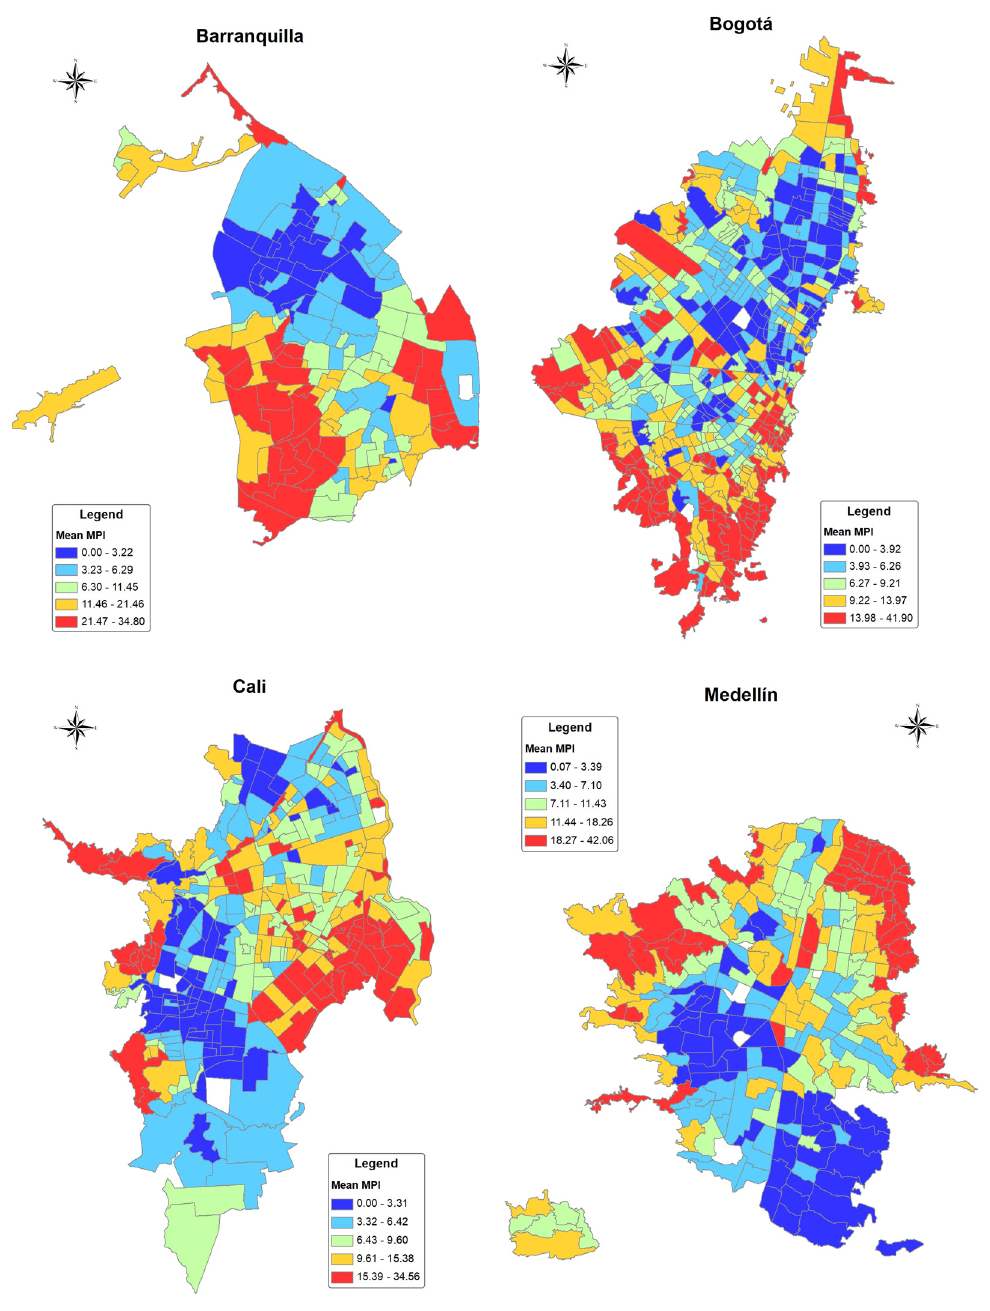
Figure 2. Multidimensional poverty index (MPI) at census sector level by city in Colombia 2018.